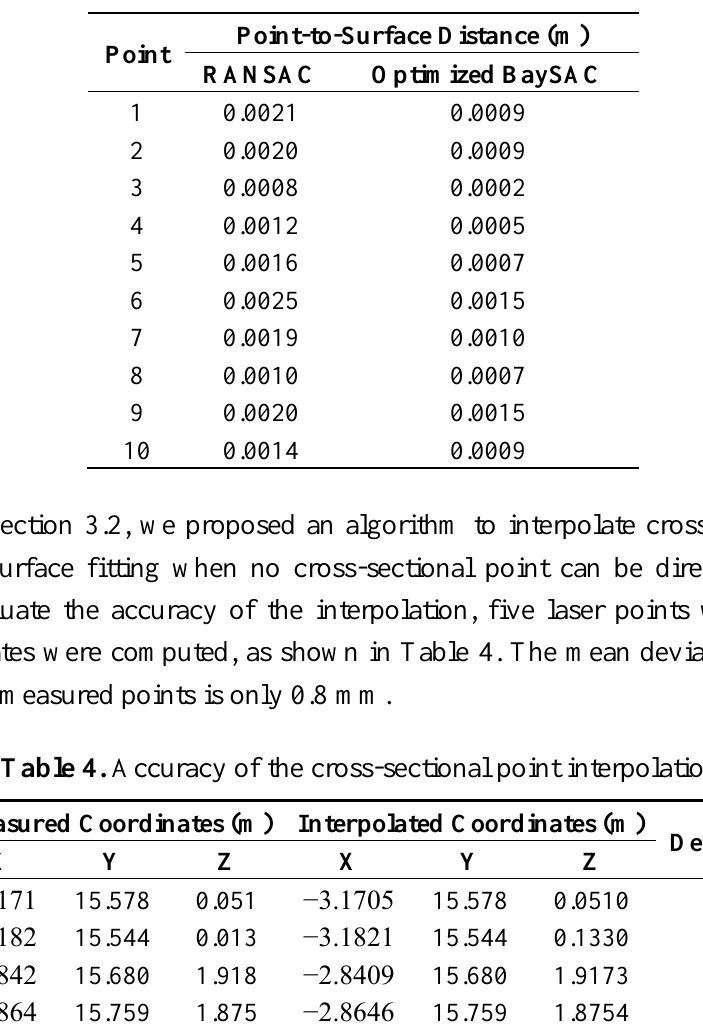
Table 3. Accuracies of quadric parametric surface fitting.